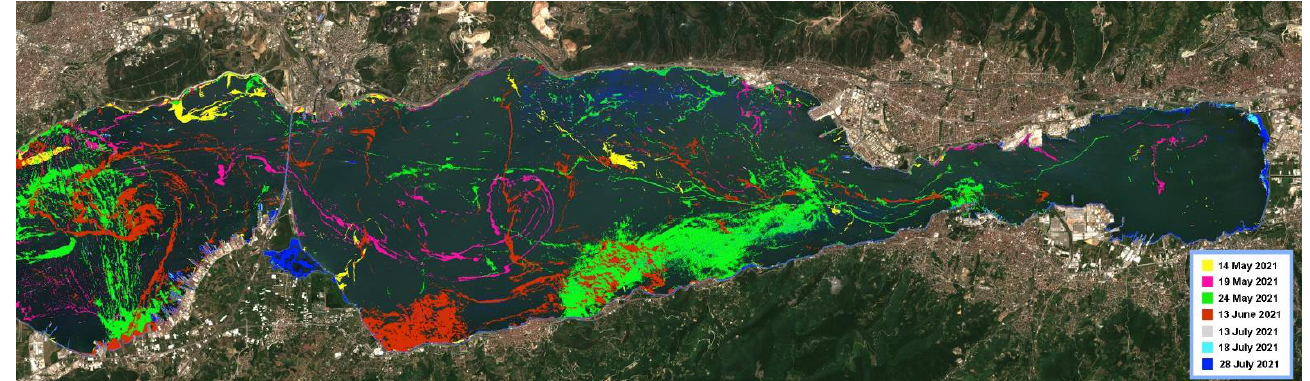
Figure 6. Temporal analysis of mucilage coverage on Izmit Bay using AFAI index.